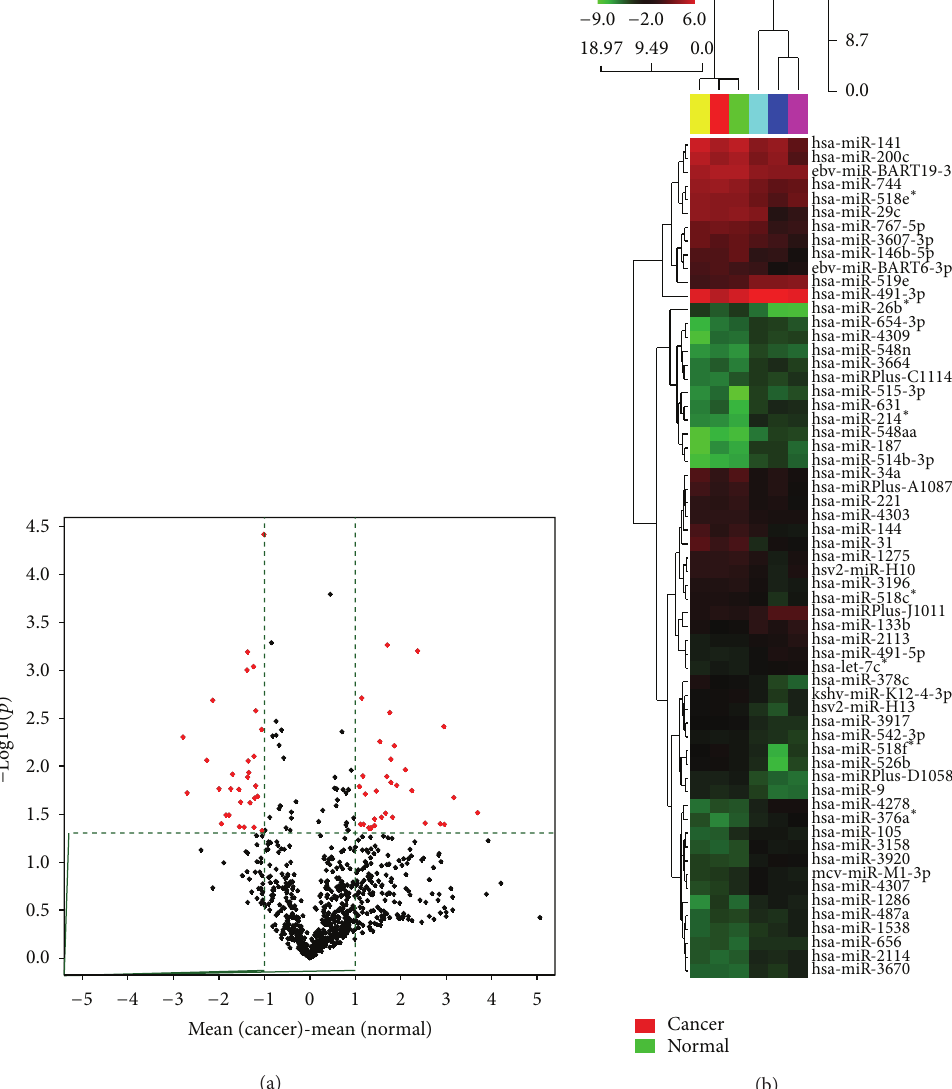
Figure 2: (a) Volcano plot showing the relative expression of miRNA genes form a one-class 𝑡 -test. The vertical lines correspond to 2.0-fold up and down, respectively, and the horizontal line represents a 𝑃 value of 0.05. The red point in the plot represents the differentially expressed genes with statistical significance. (b) Hierarchical clustering for differentially expressed miRNAs in cancer versus normal pass volcano plot (fold change ≥ 2.0). Red indicates high relative expression, and green indicates low relative